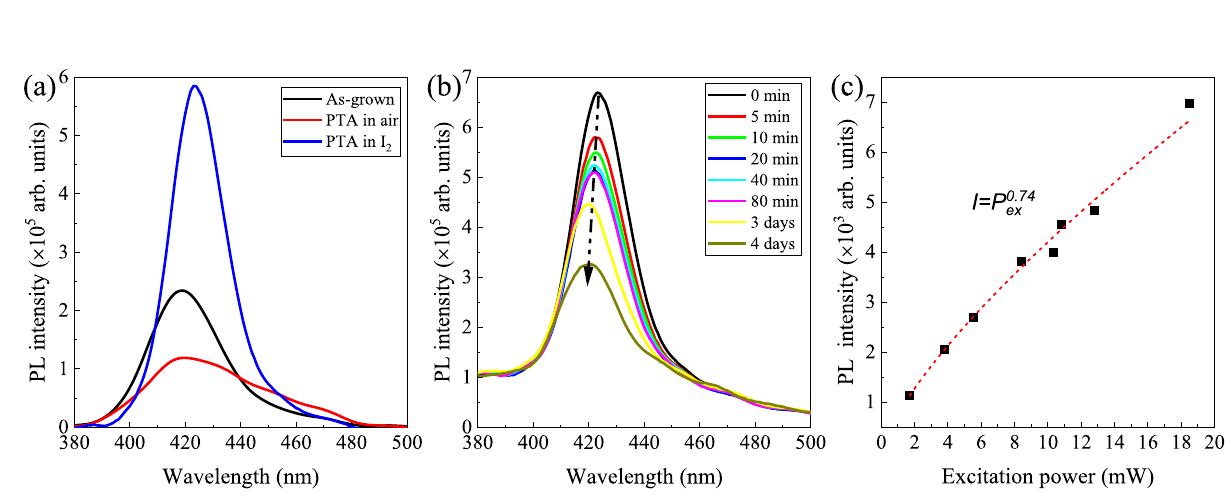
Fig. 3 | Steady-state PL emissions. a Steady-state PL spectraof CuI thin fi lms with different treatments, i.e., as-grown (black), PTA in air (red) and PTA in I 2 vapor (blue). b PLintensity ofas-grown CuI thin fi lm withdifferent aging time in ambient